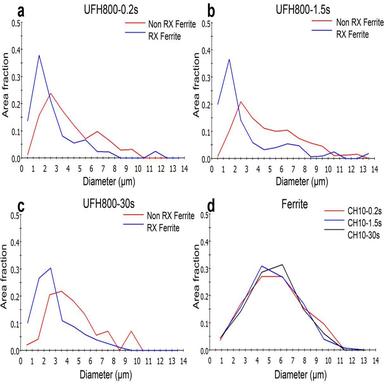
a), b), c) Representation of the equivalent circle diameter (ECD) versus area fraction for recrystallized (RX) and non-recrystallized (Non RX) ferrite after UFH with soaking for 0.2, 1.5 and 30 s, respectively; d) grain diameter versus area fraction for ferrite after CH treatment. Data are obtained from the EBSD measurements. (For interpretation of the references to color in this figure, the reader is referred to the web version of this article).